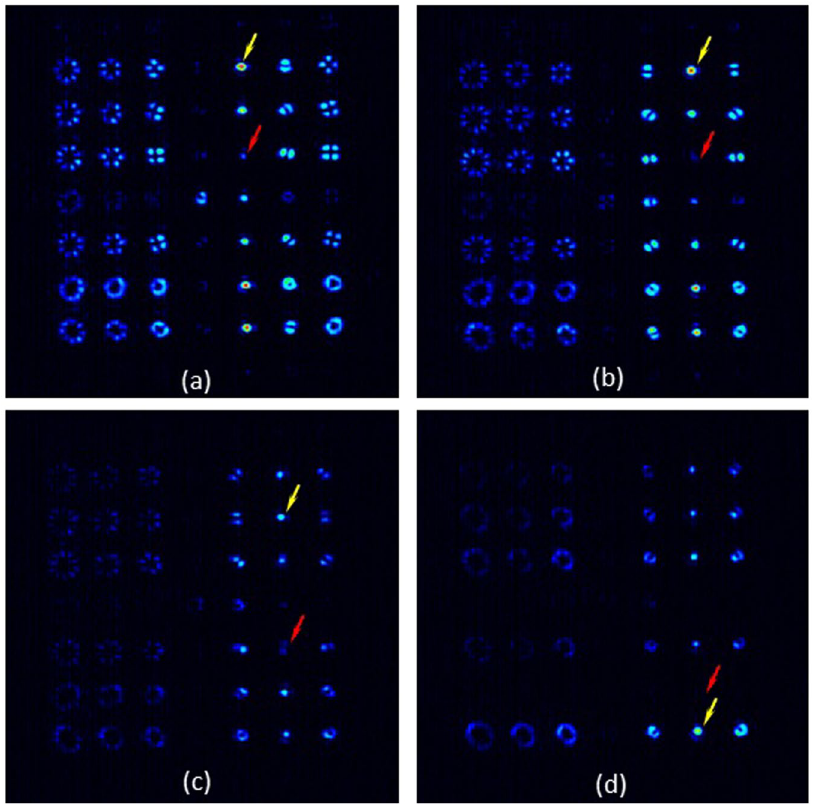
Figure 6. Experimental detection of vector beams generated with an external q -plate illuminated with different polarizations: ( a ) Input q = 1/2 plate illuminated with linear vertical polarization, ( b ) Input q = 1 plate illuminated with linear vertical polarization, ( c ) Input q = 1 plate illuminated with linear polarization oriented at 45° and ( d ) Input q = 1 plate illuminated with RCP polarization. The yellow arrow points the bright spot indicating the detection of a vector beam, while the red arrow points the null diffraction order corresponding to the orthogonal